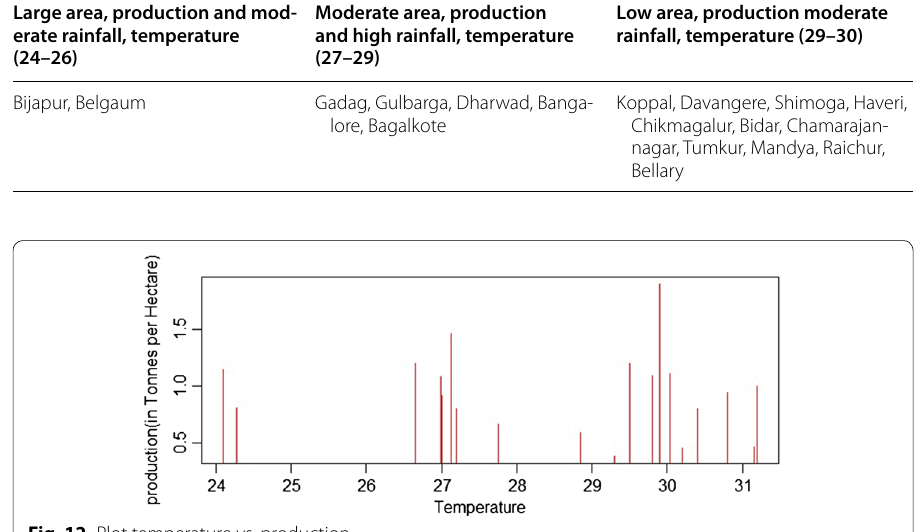
Table 3 P value test: significant attributes